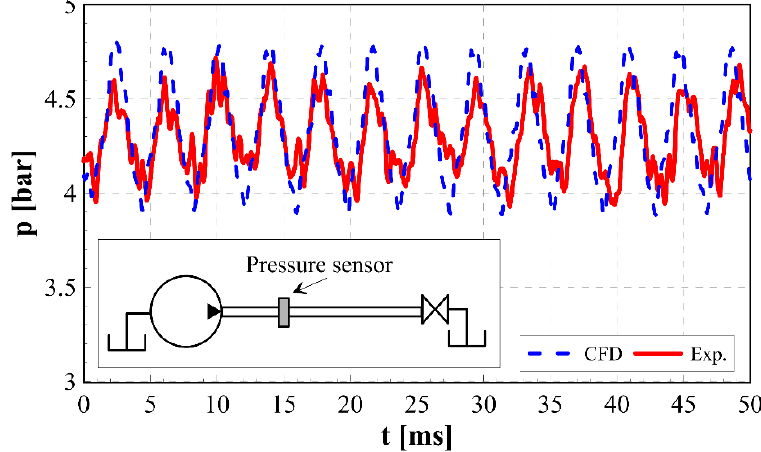
Figure 7. Pressure validation close to the middle of the delivery line (1200 rpm, 4 bar).